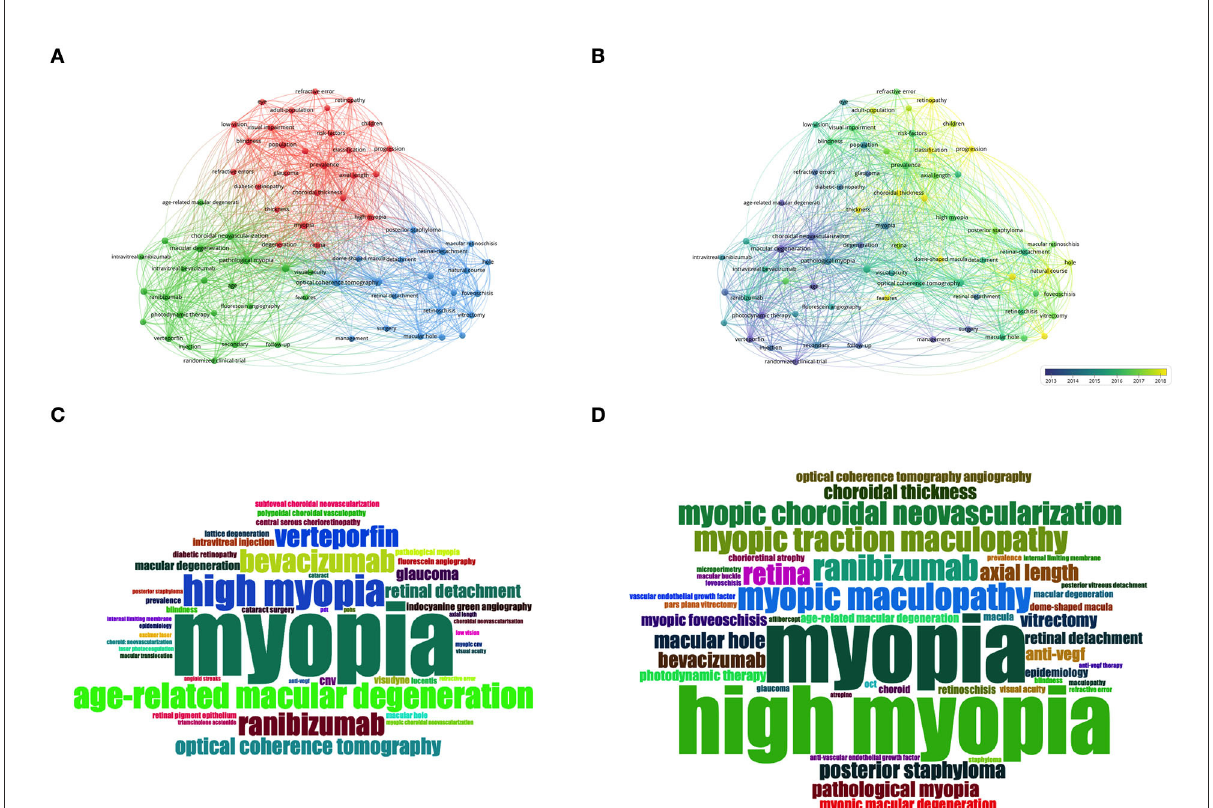
FIGURE4 Keywords analysis by VOSviewer and R. (A) Co-occurrence map of keywords in titles and abstracts. Keywords were classified into 3 clusters by co-occurrence frequency, including an epidemiology-related cluster (in red), a treatment-related cluster (in green), and a lesion-related cluster (in blue). (B) Color-coded map of keywords by the average time of appearance. Blue keywords appeared earlier, while yellow keywords appeared more recently. (C) The word-cloud map of the most frequent keywords from 2000 to 2010. (D) The word-cloud map of the most frequent keywords from 2011 to August